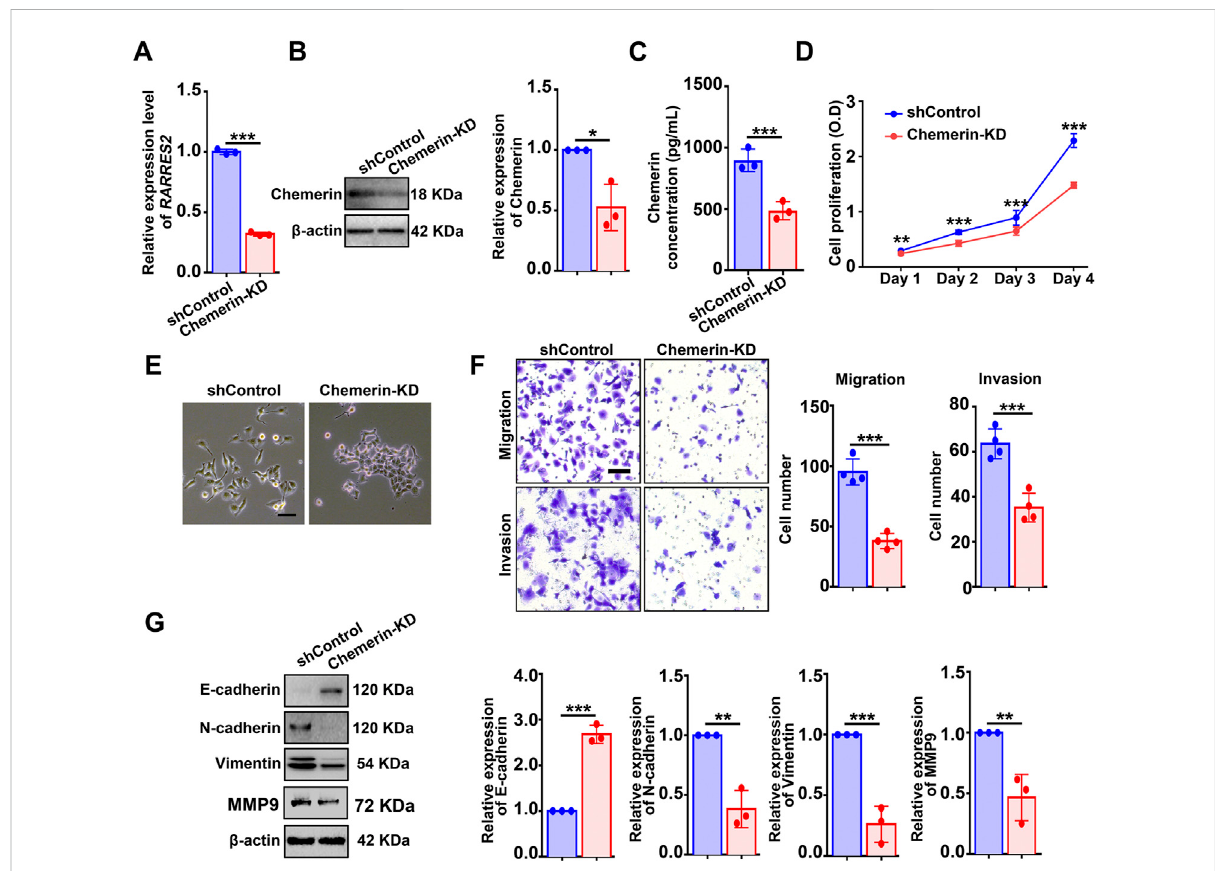
FIGURE 2 Knockdown of chemerin impairs the viability and mesenchymal features of hEM15A cells. (A – C) Chemerin mRNA and protein levels in hEM15A cellsstablyexpressedscrambledshRNA(shControl)andshRNAtargetingchemerin(chemerin-KD)weremeasuredbyqPCR,westernblot,andELISA. (D) CCK-8 assay was used to access the cell viability. (E) Representative images of cellular morphology. Scale Bars, 50 μ m. (F) Transwell assay was utilized to evaluate cell migration and invasion ability, and the quantitative data was shown in the diagrams. (G) E-cadherin,